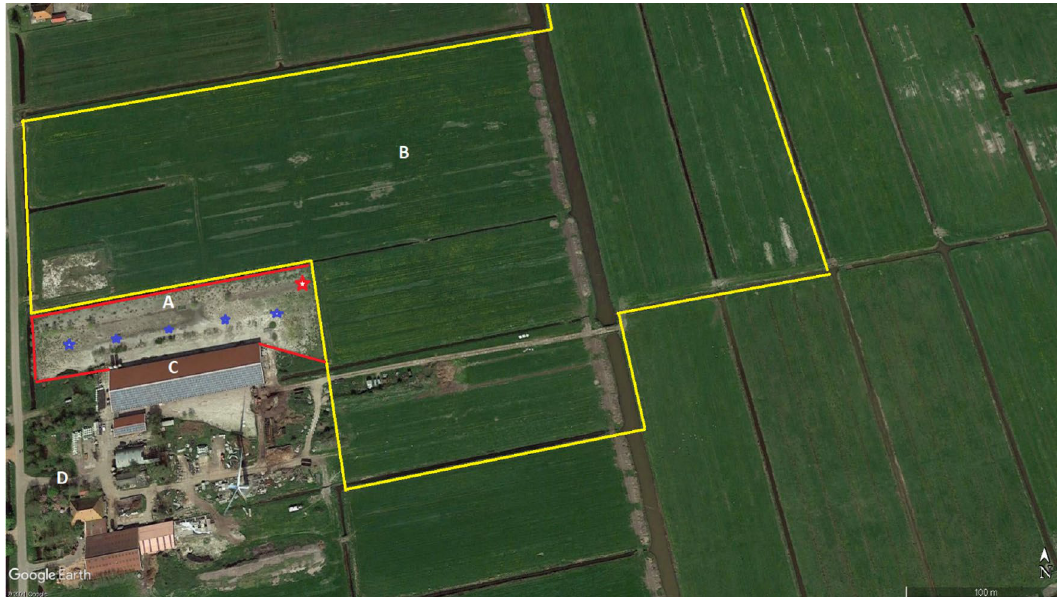
Figure 1. Aerial view of the layer farm, with the free-range study area (A) directly connected to the poultry house (C), and the surrounding grass pastures (B) that formed the total surface of the free-range area (A + B). The red line marks the fence. The area within the yellow line (B) is the range of the laser during daylight laser beaming. The area within the red line (A) is the range of the laser during night laser beaming. The red star (upper right corner in area A) indicates the position of the laser. The blue stars in area A indicate the position of the wide-angle video-cameras. The farm house is indicated by D (source: Google Earth, 2021